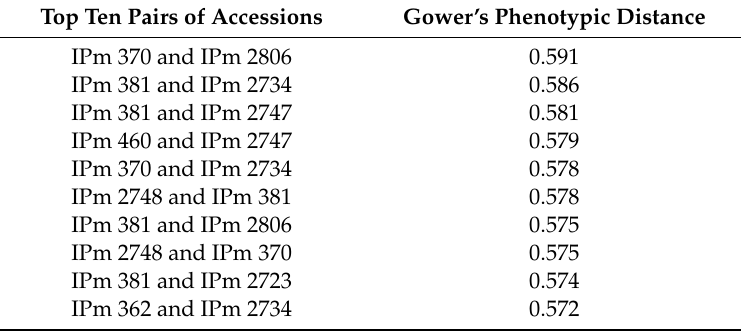
Table 5. Most diverse pairs of accessions identified in the entire set using Gower’s distance. Top Ten Pairs of Accessions